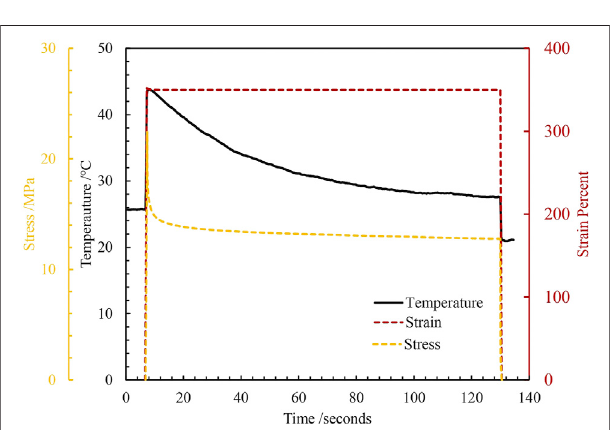
FIGURE 6 | Temperature pro fi le, stress and strain as a function of test time for N234 reinforced natural rubber rapidly extended to 350% strain, held for 2 min and rapidly